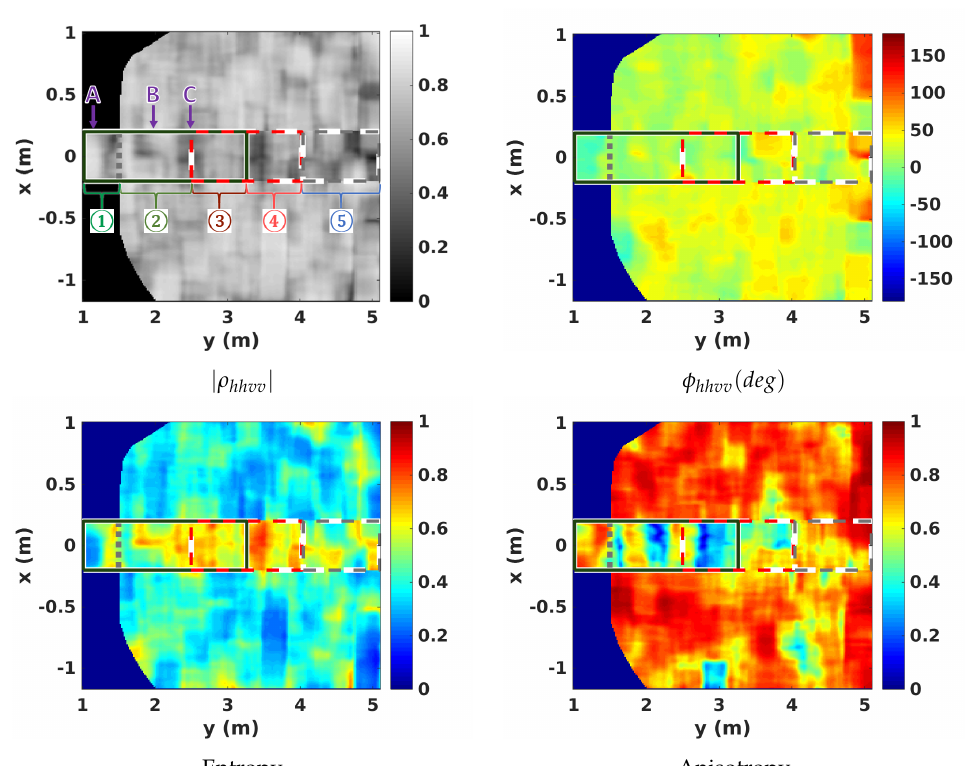
Figure 9. 2D polarimetric features of the VoG